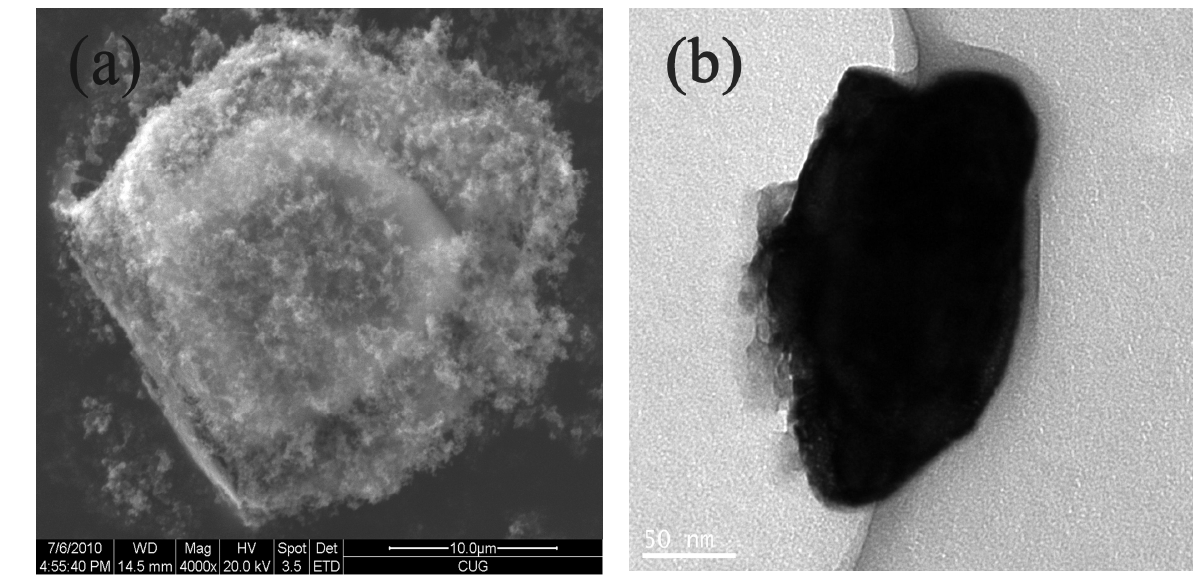
Figure 3. ESEM and TEM images of AB/S-4. ( a ) ESEM; ( b ) TEM.